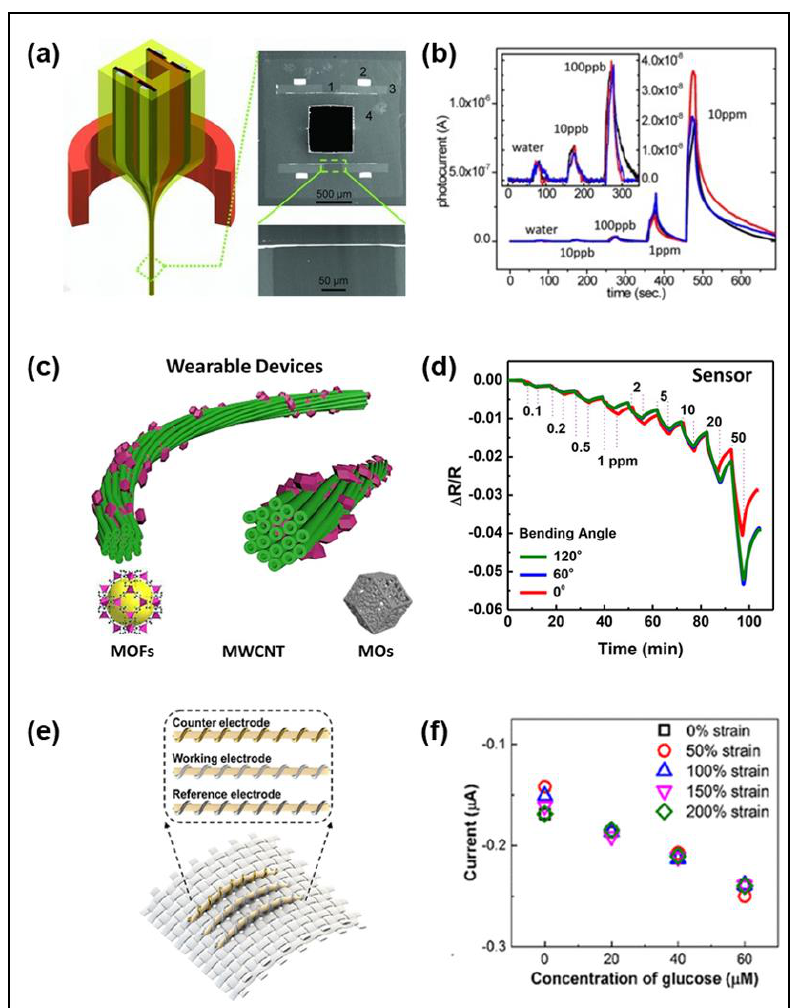
Figure 3. Chemical sensing fiber. ( a ) Cross-sectional SEM image of the chemiluminescent fiber. ( b ) Sensitivity to peroxide vapor down to 10 ppb. Reproduced with permission from [55], Copyright (2012), Wiley. ( c ) Schematics of MOFs/MWCNT fiber. ( d ) Sensitivity to NO2 down to 0.1 ppm under bending. Reproduced with permission from [47], Copyright (2017), American Chemical Society. ( e ) Schematic of the fibers integrated into a textile. ( f ) The calibration plot of the chronoamperometric responses of the fiber up to 200% strain. Reproduced with permission from [39], Copyright (2019), American Chemical